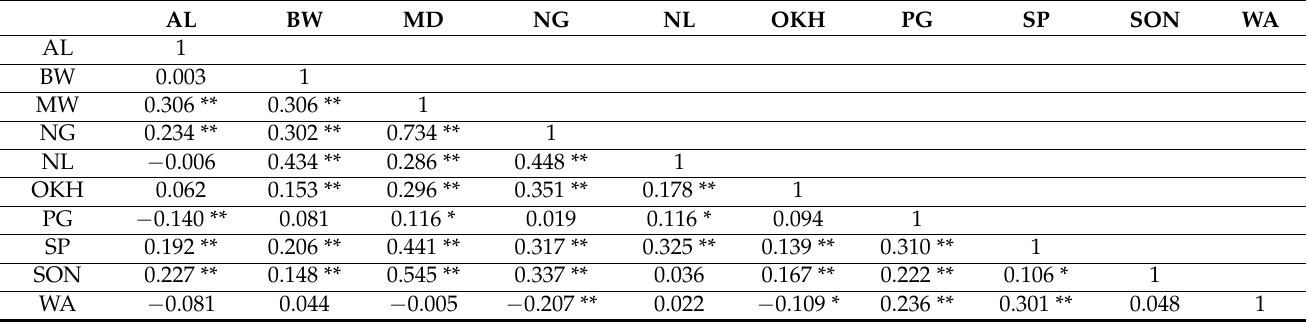
Table 2. Correlation between the different monitoring stations for the pre-pandemic